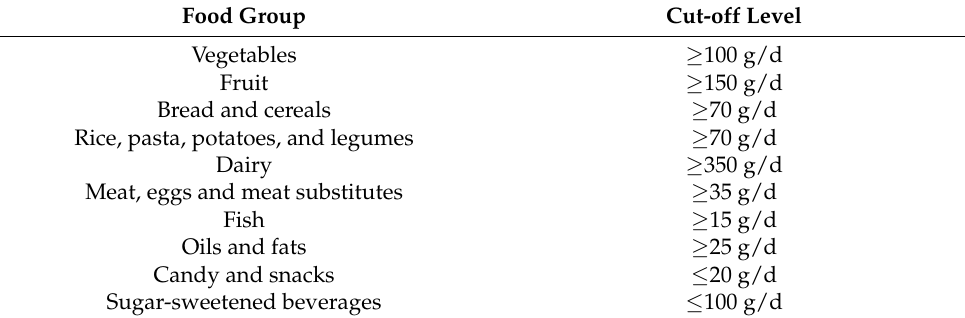
Table 1. Food groups and cut off